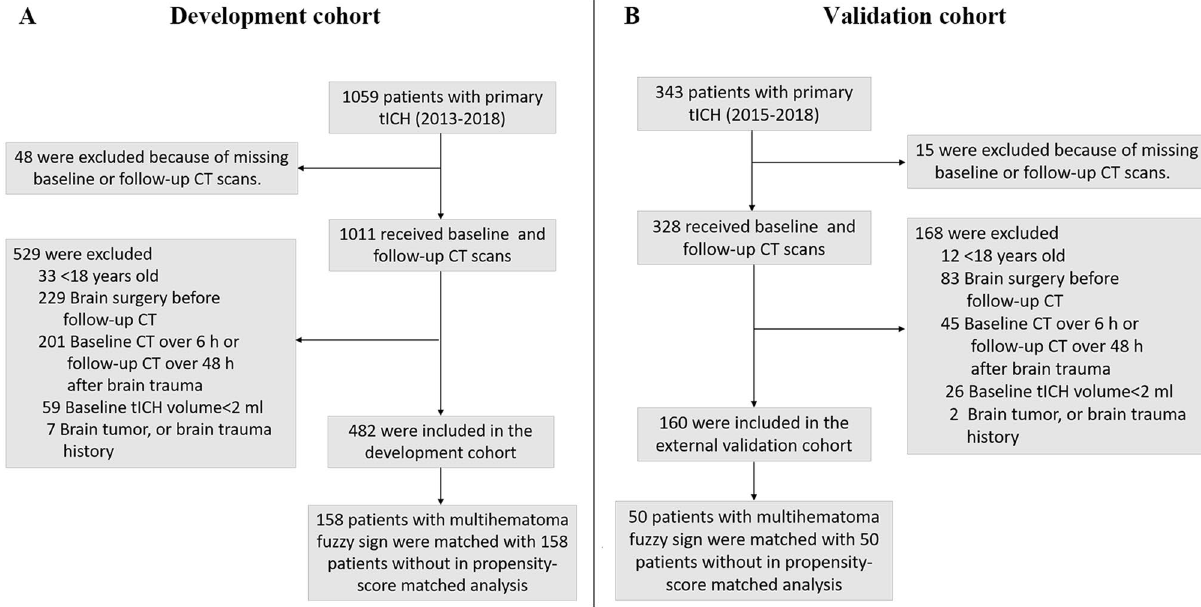
Figure 1. Flowchart of patient selection process including inclusion and exclusion criteria. Patients in the development cohort were selected from First Affiliated Hospitals of Shantou University Medical College and Second Affiliated Hospitals of Shantou University Medical College between May 2013 and June 2018 ( A ). Patients in the validation cohort were selected from Affiliated Jieyang Hospital of Sun Yat-sen University between March 2015 and June 2018 ( B ). CT noncontrast computed